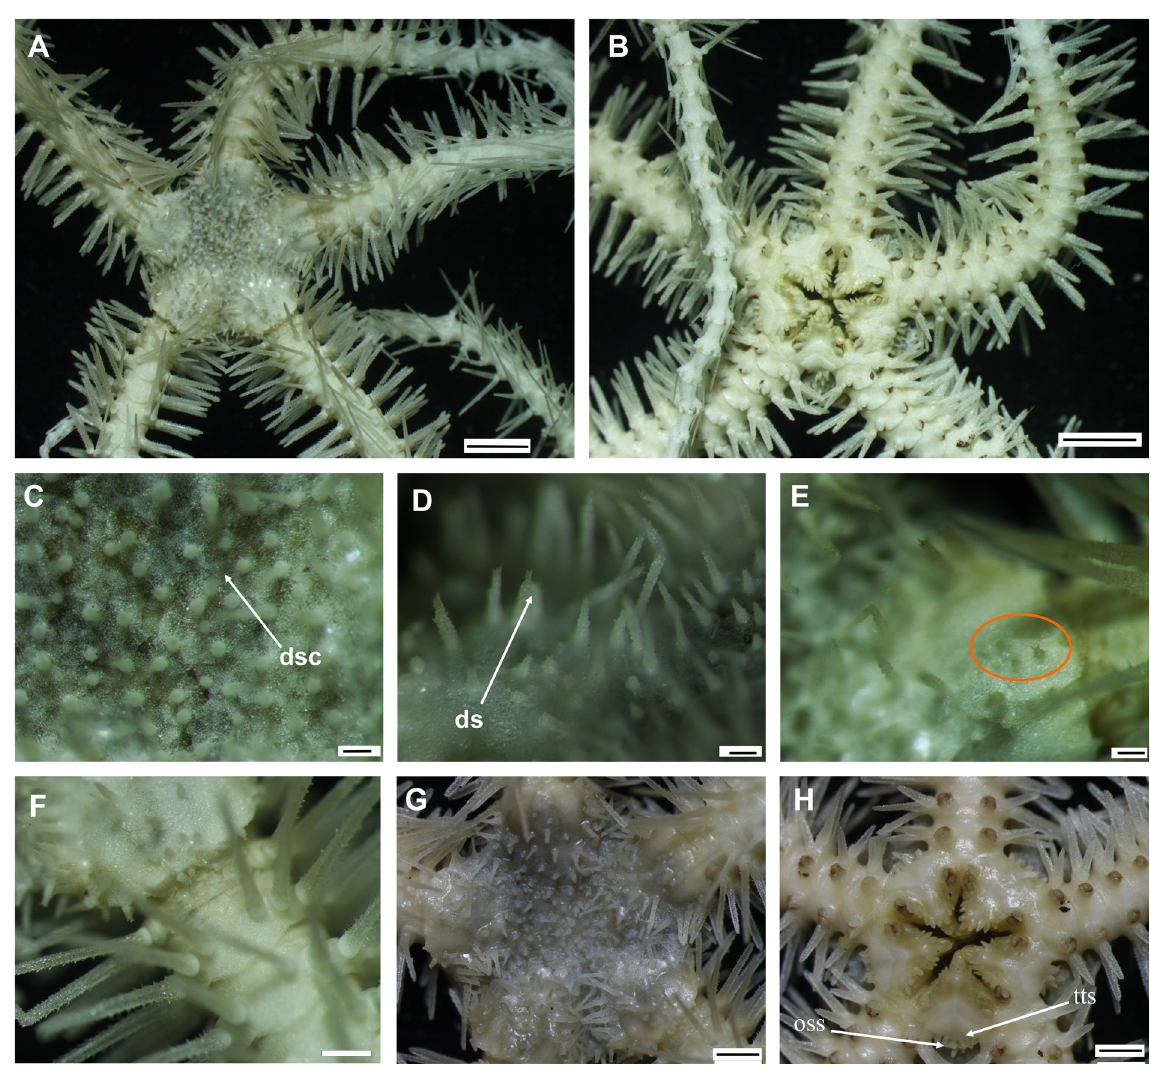
Fig. 17. Ophiopristis shenhaiyongshii sp. nov., holotype (IDSSE EEB-SW0022). A . Dorsal side of the specimen. B . Ventral side of the specimen. C . Overlapping disc scales. D–F . Various sizes of disc spines. G–H . Fresh specimen. G . Dorsal disc. H . Ventral disc. Abbreviations: ds = disc spine; dsc = disc scale; oss = oral shield spine; tts = thin transparent skin. Scale bars: A–B = 2 mm; C–E = 200 µm; F = 500 µm; G–H = 1